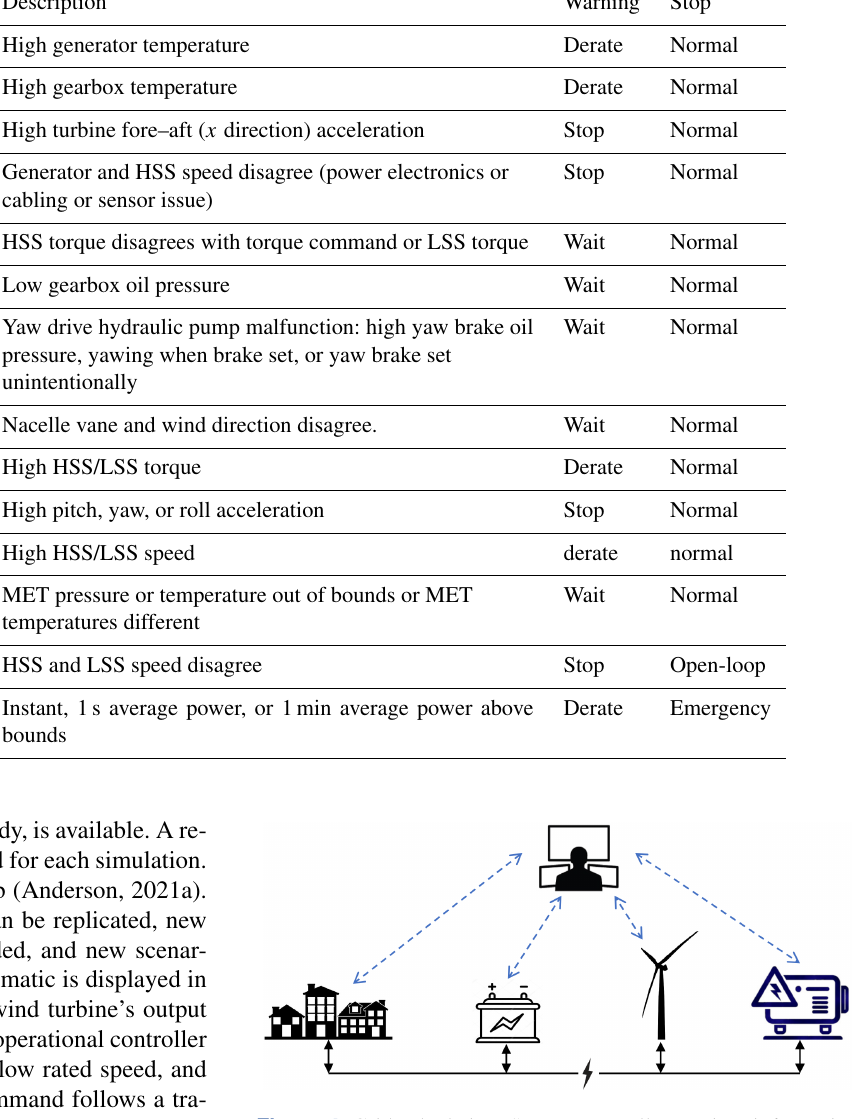
Figure 4. Grid calculation. System controller receives information from all nodes and gives commands to